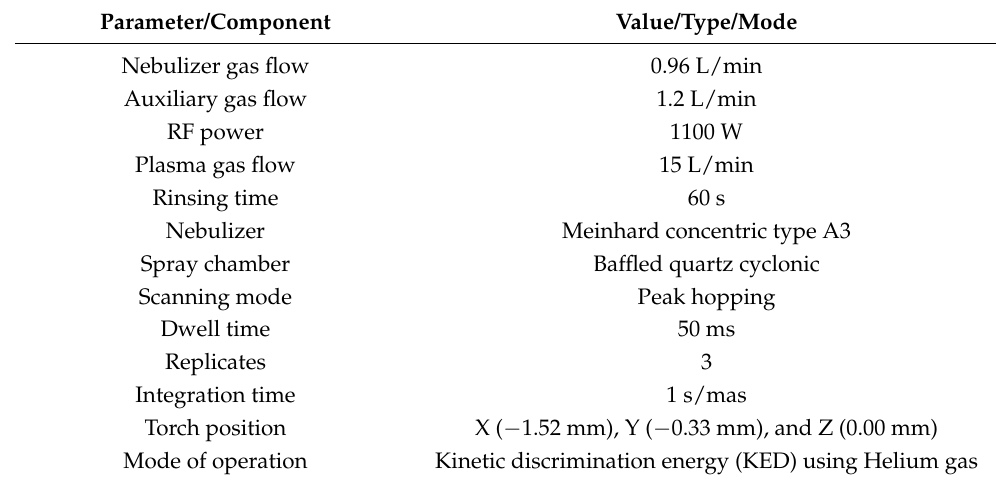
Table 1. Selected ICP-MS operating conditions for elemental analysis using the KED